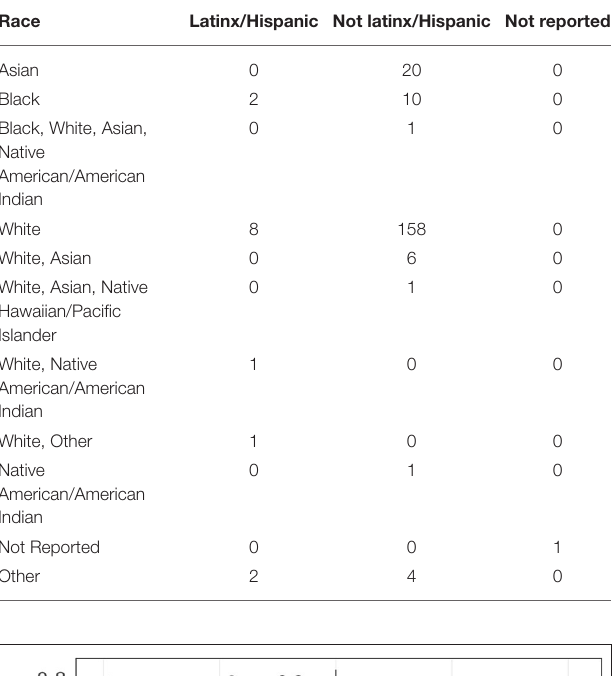
TABLE 3 | Participant demographics for Study 4.